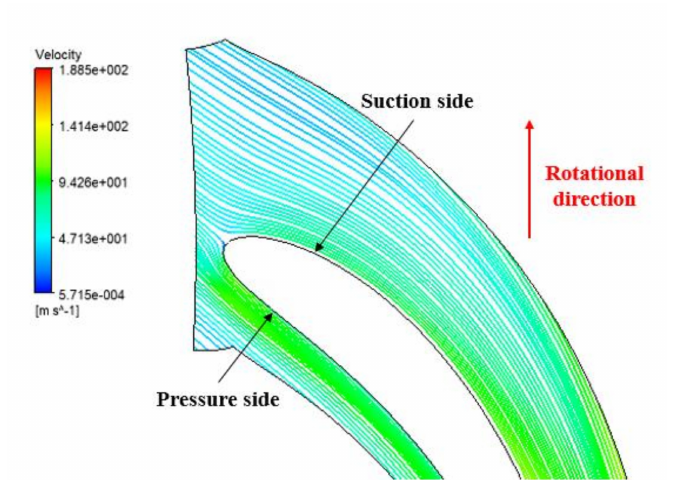
Figure 15. Streamline of the rotor blade (B point).